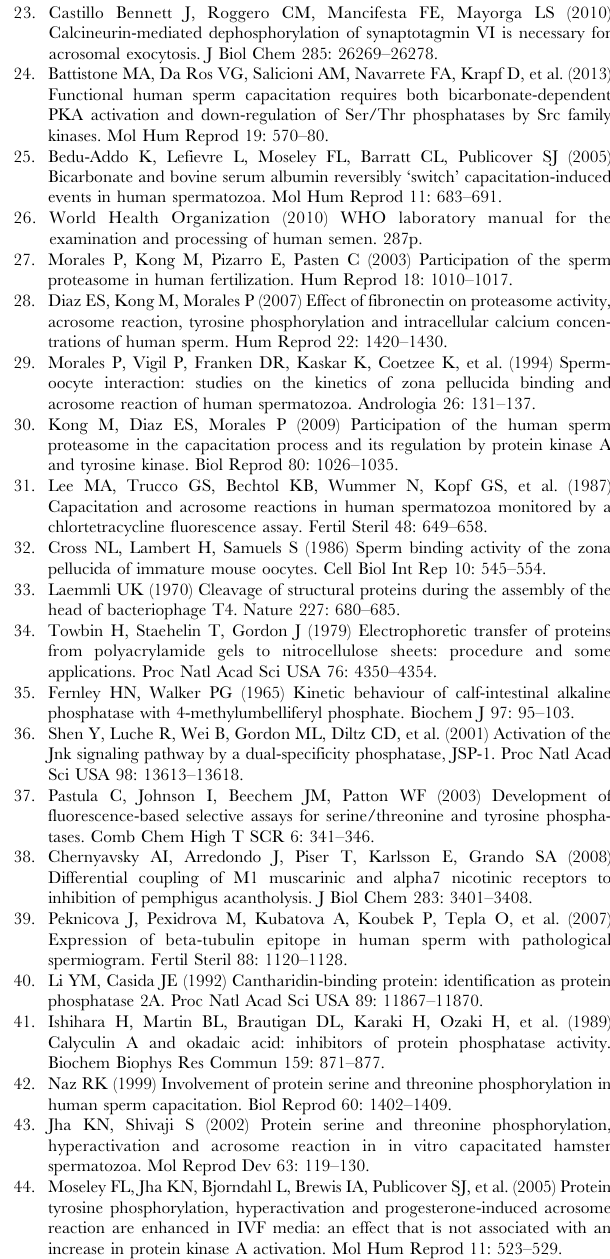
tated cells was evaluated at various times. Results were obtained from four different donors and are expressed as the mean 6 SEM of the percentage of the B pattern. *** p , 0.001. Figure S3 Effect of low concentrations of okadaic acid on the capacitation of human sperm. Sperm resuspended in CM were treated with different concentrations of okadaic acid. The percent of capacitated cells was evaluated at various times. Results were obtained from five different donors and are expressed as the mean 6 SEM of the percentage of the B pattern. * p , 0.05; *** p , 0.001.